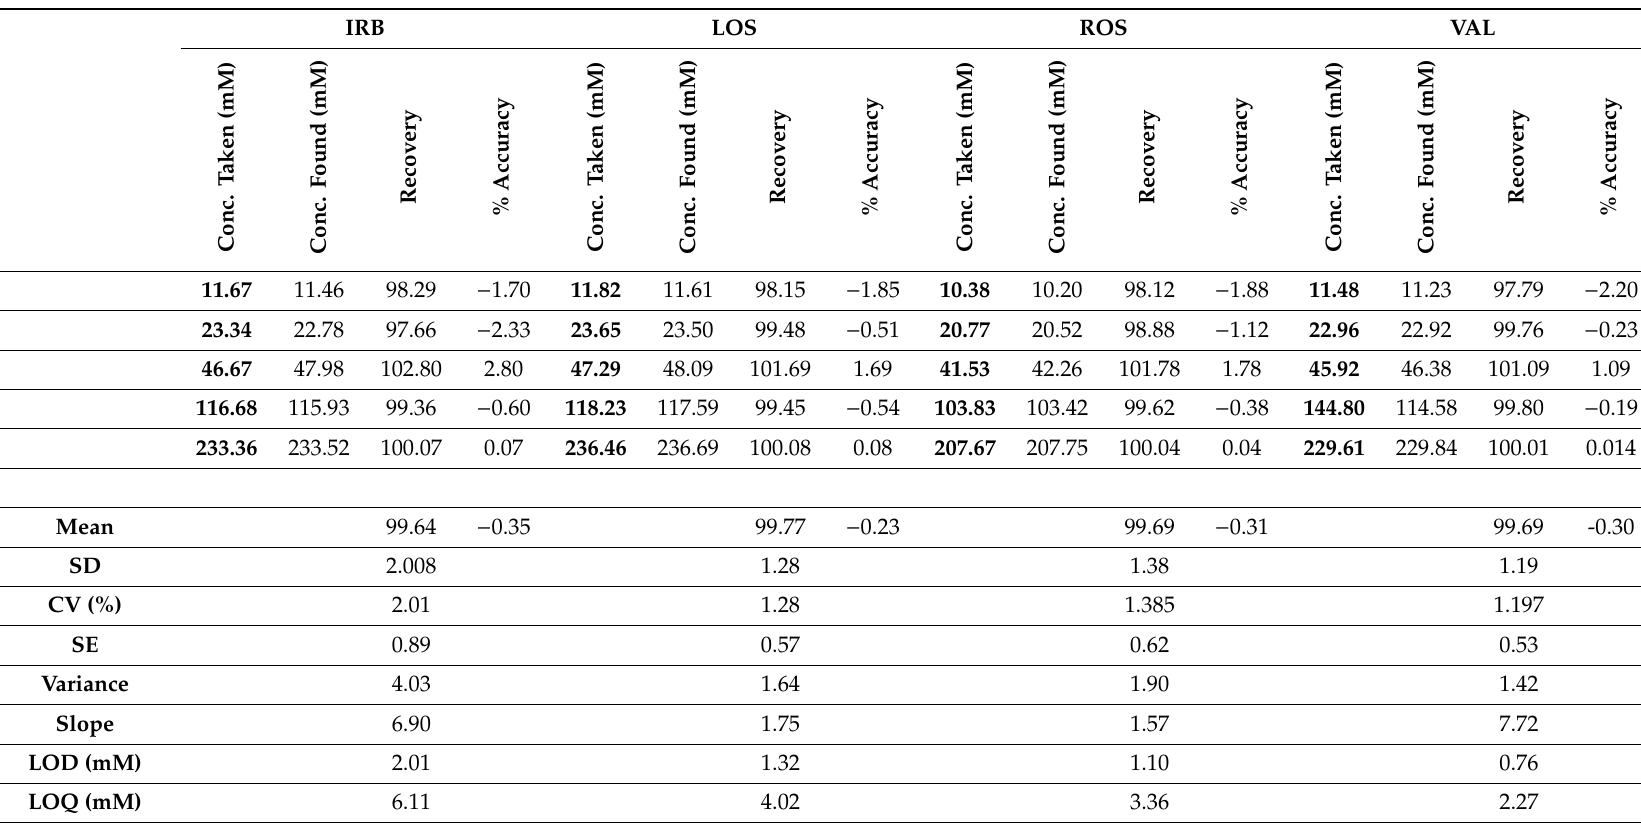
Table 2. Analytical merits for determination of irbesartan (IRB), losartan (LOS), rosuvastatin (ROS), valsartan (VAL), atorvastatin (ATR), lovastatin (LOV), olmesartan (OLM), and simvastatin (SIM) in pure samples using the proposed